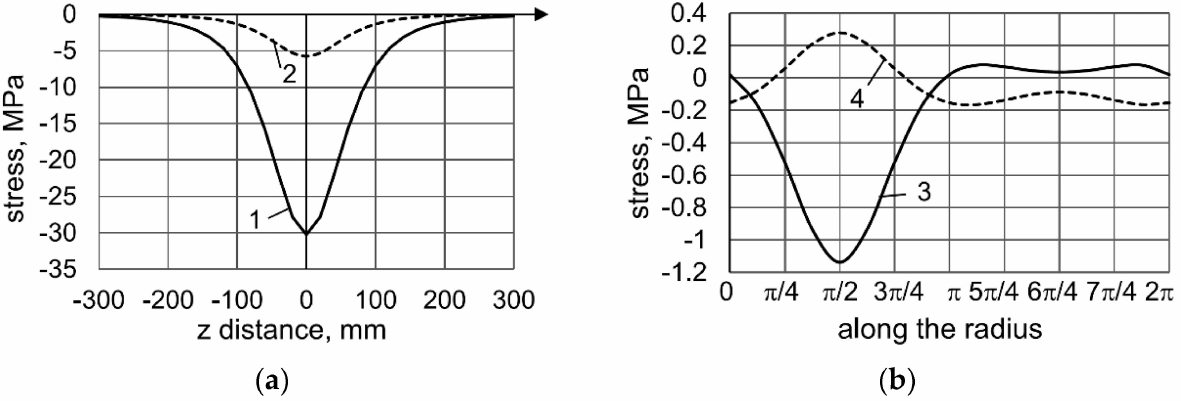
Figure 3. Stressed state: ( a ) at the upper boundary of the layer along the z axis at x = 0; ( b ) on the surface of a cylindrical cavity at z = 0; 1 – σ y ; 2— σ x ; 3— σ ρ ; 4— σ φ . The stresses σ x (Figure 3a, line 2) and σ z at the upper boundary of the layer along the z axis coincide. The highest stress values are realized in the section z = 0 and are equal to σ y = –30.2475 MPa, σ x = –5.7514 MPa.